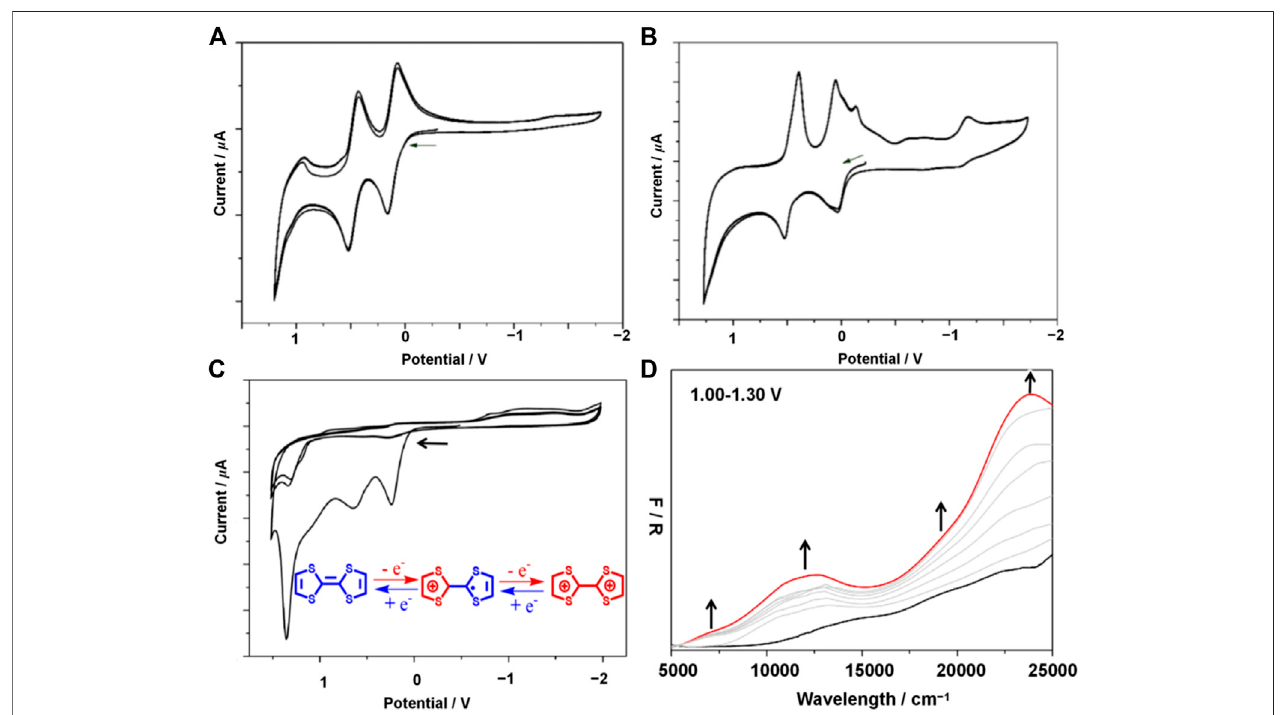
FIGURE 3 | Solution state CVs of H 2 L measured over 3 consecutive sweeps (A) , solution state CVs of [Fe Ⅱ L(CH 3 OH) 2 ] measured over 3 consecutive sweeps (B) , solid state CV for 1 obtained at 100 mVs − 1 over 3 consecutive scans (C) , solid-state UV-vis-NIR spectroelectrochemistry of 1 at 0 V (black) and 1.30 V (red) (D) . Gray spectra correspond to the spectral transition over the applied potential range of 1.00 – 1.30 V. Experiment performed in 0.1 mol L − 1 TBAPF 6 in CH 2 Cl 2 . Arrows denote the direction of forward scan.